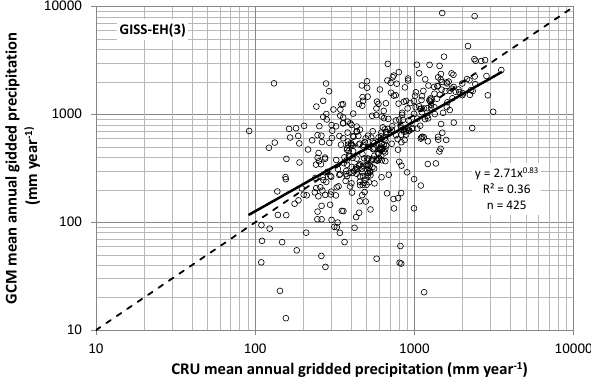
Figure 2. Comparison of GISS-EH(3) model estimates of observed mean annual precipitation with CRU estimates. (Based on untrans- formed precipitation NSE = − 0.535, rank 46 of 46 runs, and R 2 = 0 .